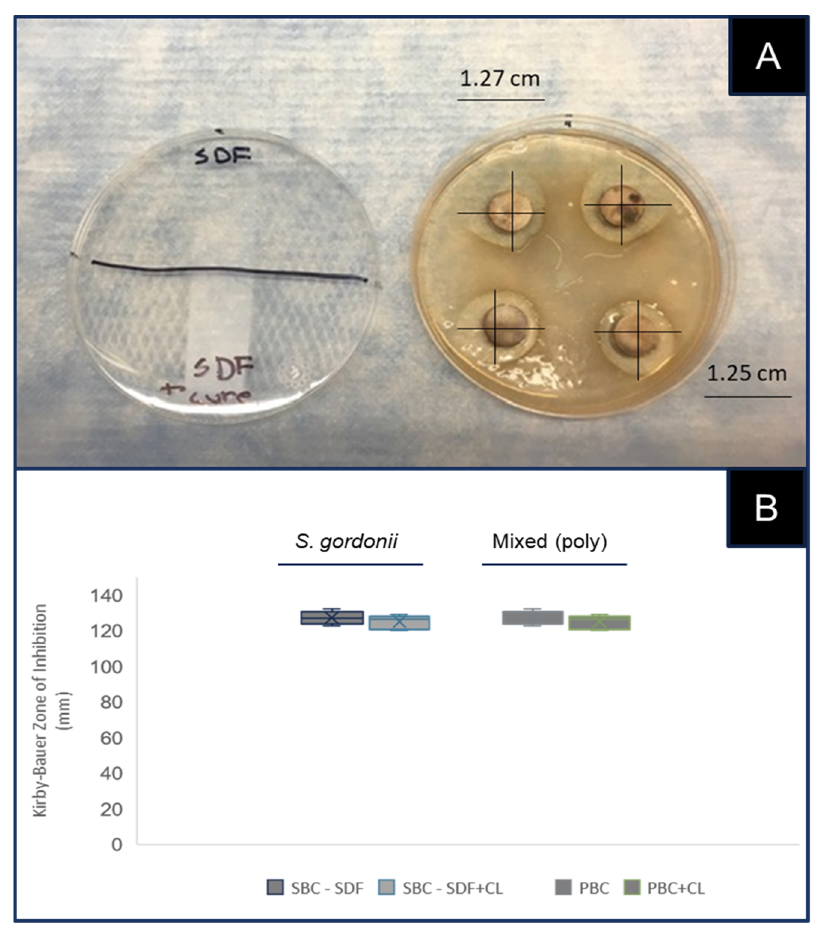
Figure 1. Zone of Inhibition test for antimicrobial activity (ZIT-AA) with Gram-positive and mixed bacterial cultures. ( A ) Visual inspection of ZIT-AA revealed that all treatments (SDF, SDF with light curing) created distinct ZIT-AA. ( B ) Measurements for ZIT-AA and single bacterial culture or SBC ( S. gordonii ) for SDF = 127.16 mm, and 125.2 mm with SDF combined with light curing: p = 0.887. The ZIT-AA for the polybacterial culture or PBC (mixed bacteria) with SDF = 126.11 mm, and 124.5 mm with SDF combined with light curing, p = 0.771. Graph displays box-and-whisker plot, which displays upper and lower quartiles, with mean denoted by X.